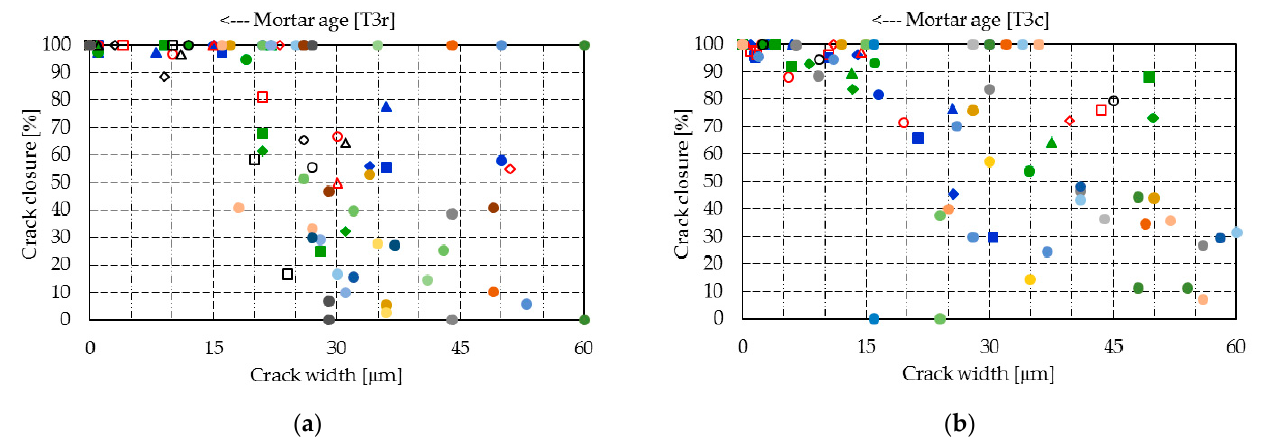
Figure 8. Segmented crack closures—markers correspond to the readings of each crack segment: ( a ) T0r–T3r; ( b ) T0c–T3c.